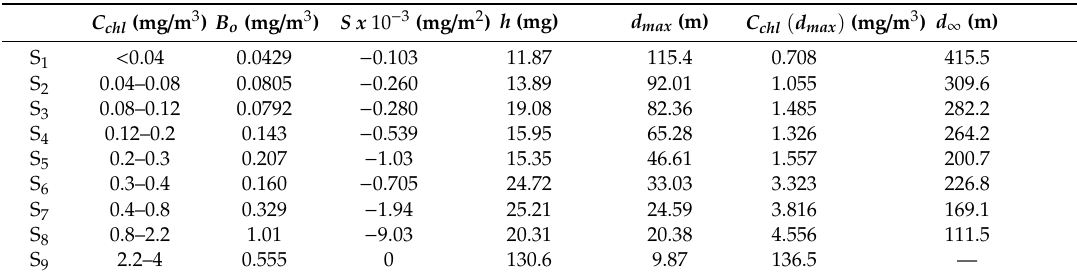
Table 3. Values for S 1 –S 9 chlorophyll concentration profiles